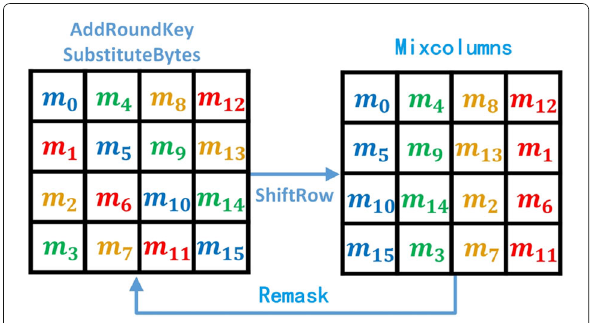
Fig. 7 The masks in our first-order masking scheme